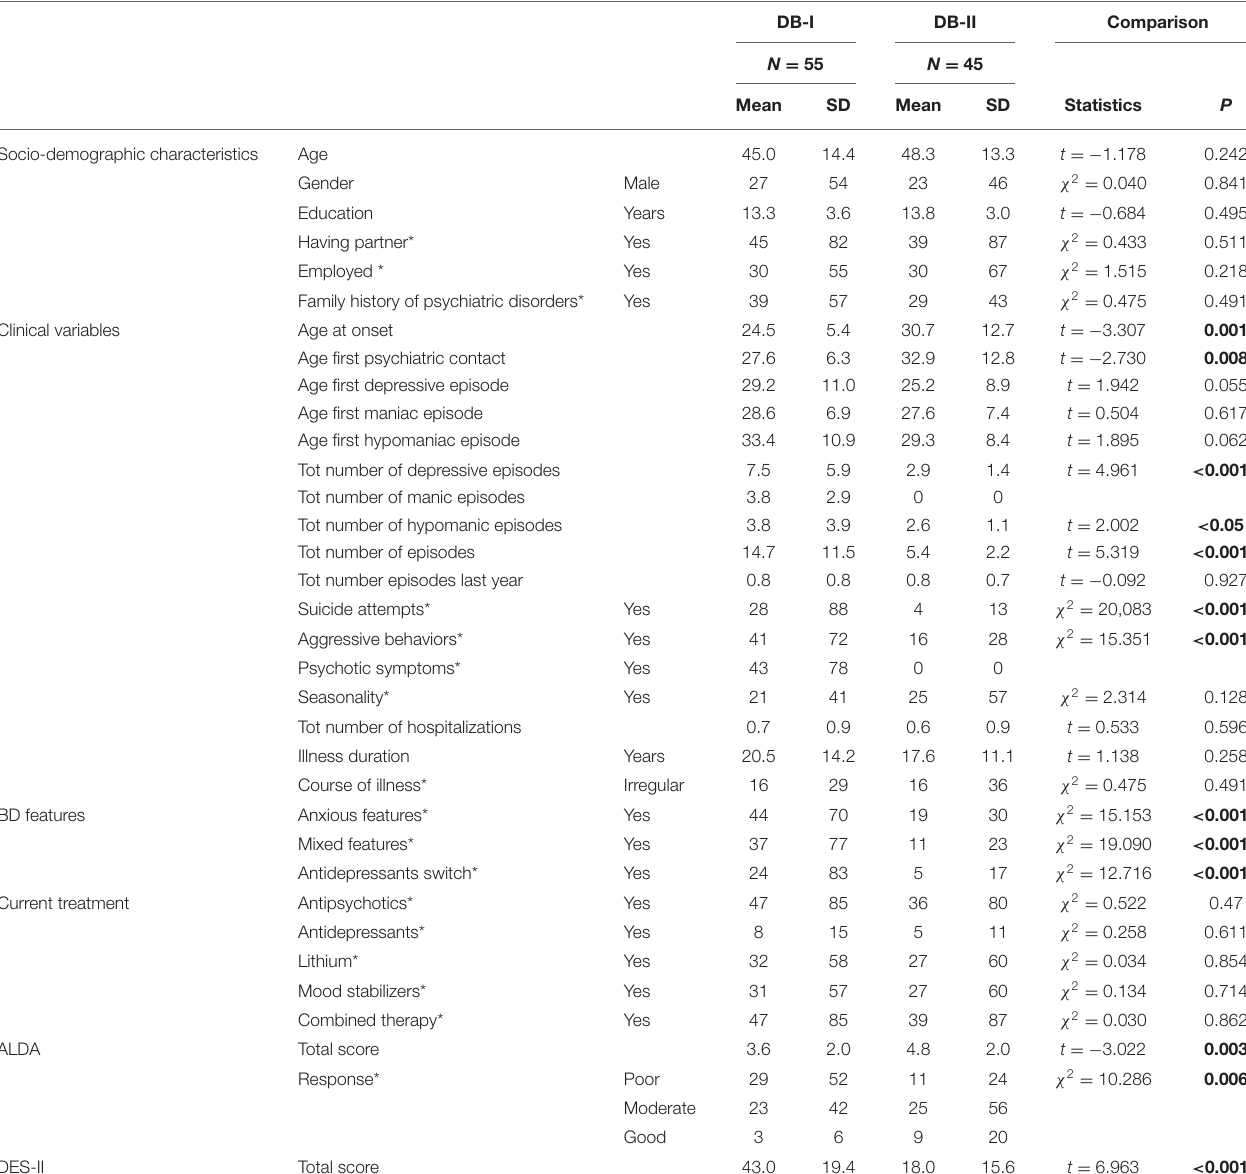
TABLE 1 | Socio-demographic and clinical characteristic of total